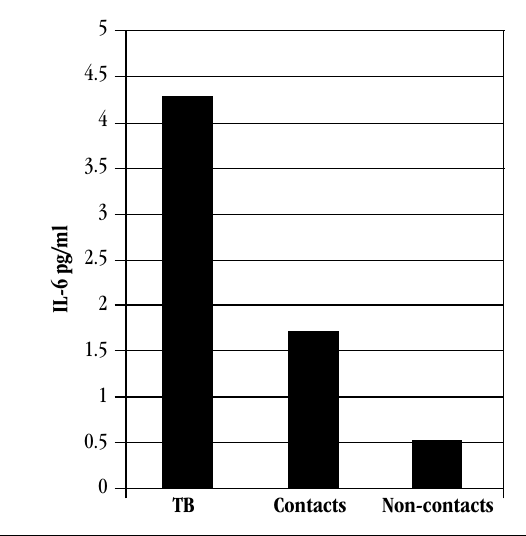
figurE – IL-6 serum levels in contact, TB and non-contact groups Values are presented in median. The variations (pg/ml) were TB = 0.5-24, contacts = 0.96-4.8 and non-contacts = 0-2.8. p < 0.0001 when the three groups were contrasted. TB: pulmonary tuberculosis.